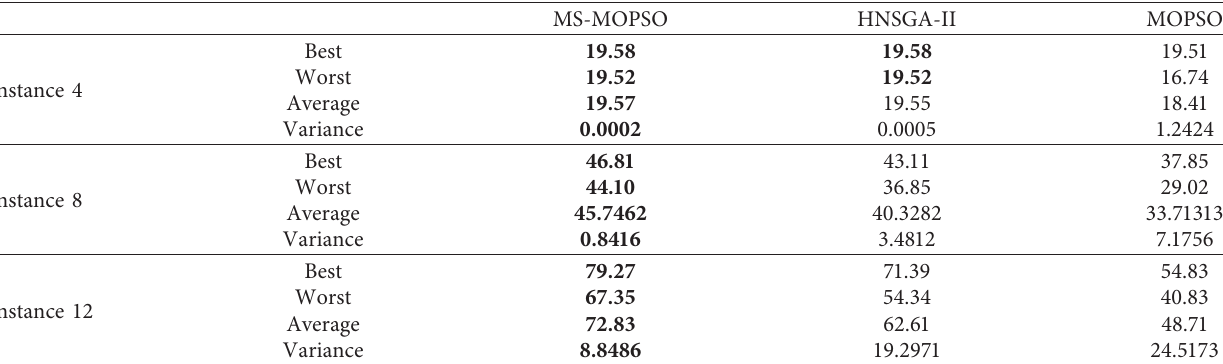
Figure 11: The running times for 12 instances. Table 5: Results of HV for three instances.